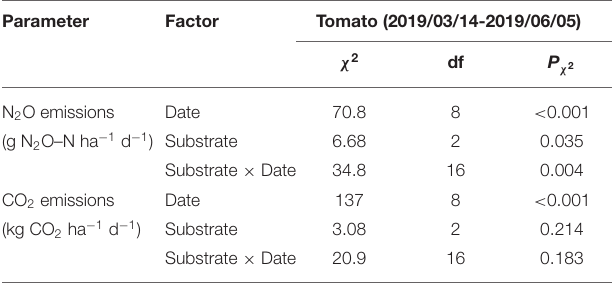
TABLE 4 | Results of linear mixed-effects models analyzing the fixed effects of utilized substrate (rock wool, perlite/wood fiber or coir), and the random effects of individual growing bags on N 2 O and CO 2 emission rates from tomato cultivation in spring 2019.